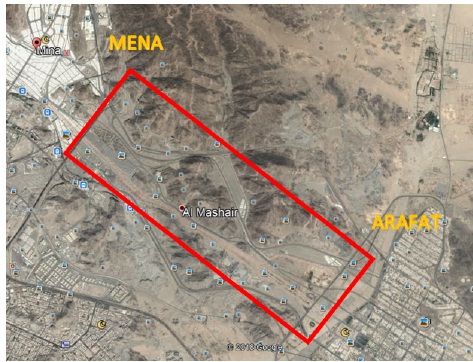
Figure 8. Rectangle coverage area with the dimensions of 6 km × 1.8